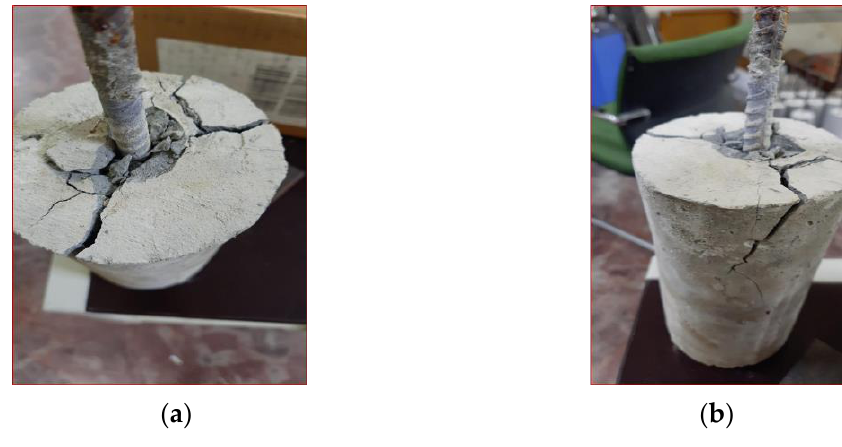
Figure 11. Different stages of failure at a displacement of ( a ) 0 mm, ( b ) 5 mm, ( c ) 10 mm, ( d ) 15 mm, ( e ) 20 mm, ( f ) Splitting.